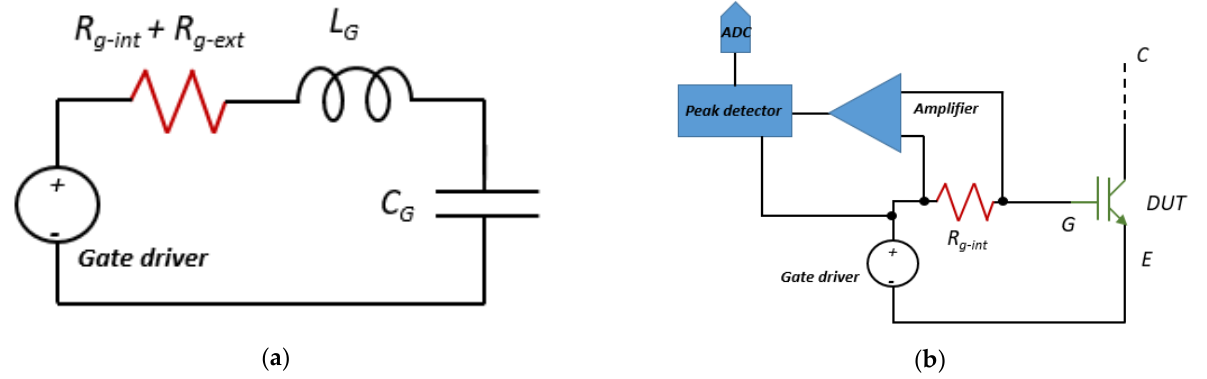
Figure 14. Gate driver RLC network. ( a ) Peak detector schematic to detect peak voltage over the external gate resistor ( b ).